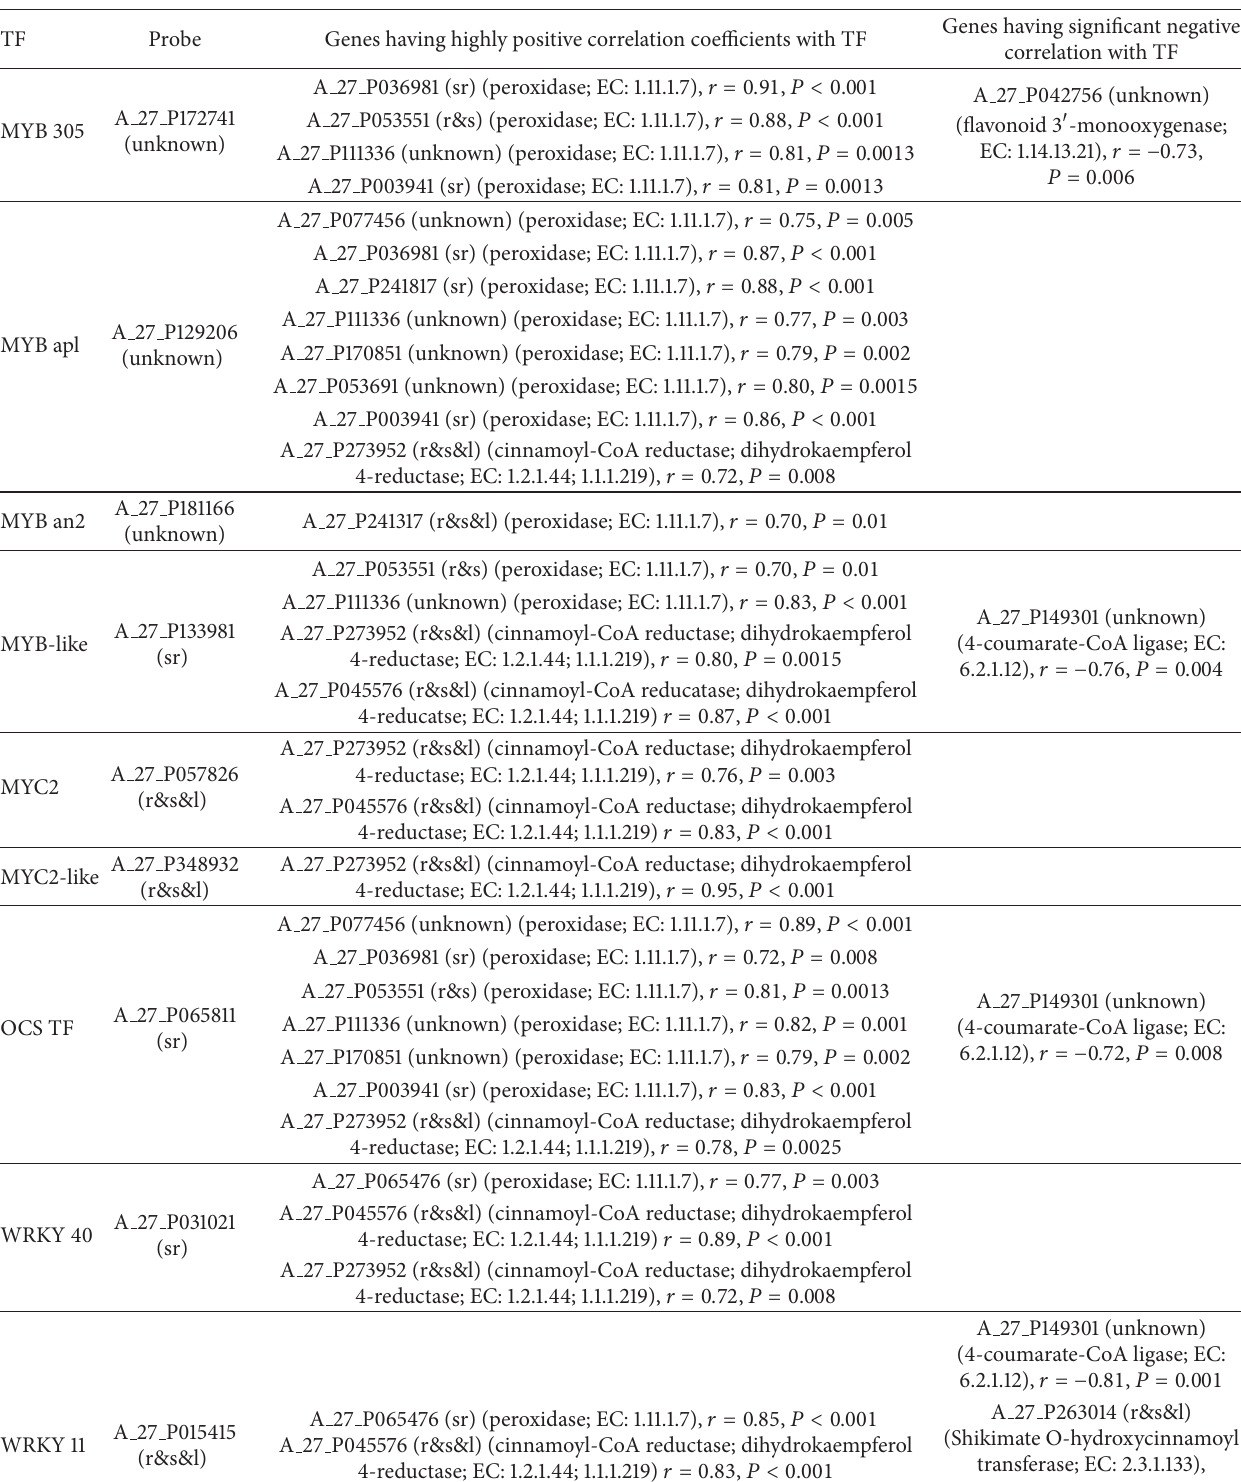
Table 3: Correlation coefficient analysis of TFs with metabolic pathway